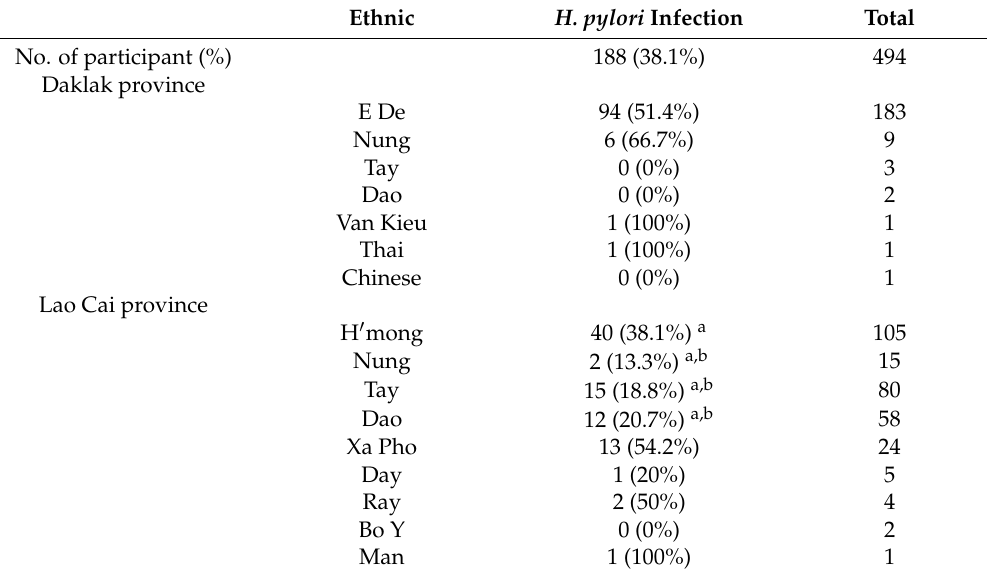
Table 1. The prevalence of Helicobacter pylori infection in a population study, in general, and in Daklak and Lao Cai provinces, in particular.